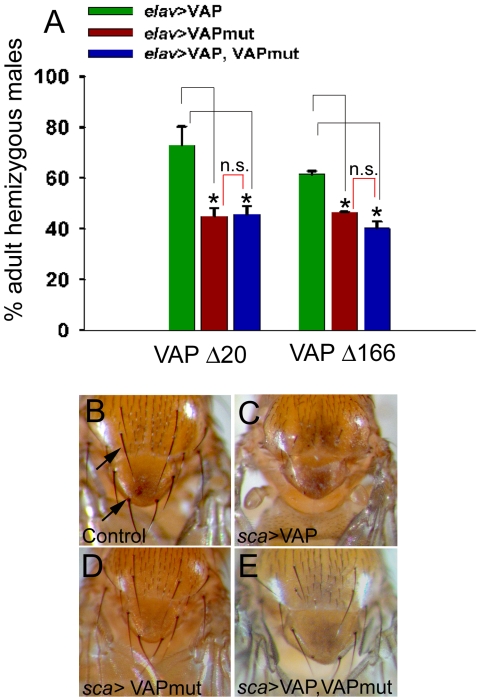
VAPP58S appears to function as a dominant negative by inhibiting the activity of wild type VAP.(A) Histogram comparing the rescue from lethality of VAPΔ20 (null mutant) and VAPΔ166 (partial deletion), using neuronal expression of VAPwt, VAPP58S, or a combination of both. The ordinate represents the percentage of mutant hemizygous males obtained (i.e., VAP mutant hemizygous males/VAP mutant hemizygous males+balancer chromosome males). Each bar represents the mean obtained from at least 2–3 independent experiments. Both VAPP58S and VAPwt are able to rescue the larval lethality observed in VAPΔ20 and VAPΔ166 mutants. However, the percentage of mutant males obtained with VAPwt is higher (72.9±7.3 for VAPΔ20 and 61.5±1.2 for VAPΔ166) as compared with VAPP58S (45.0±3.1 for VAPΔ20 and 46.6±0.06 for VAPΔ166). For each mutant, the value for wild type rescue differed significantly from mutant (p<0.05 for. Δ20 and 0.01 for Δ166; ANOVA with Sidak-Holm test). Rescue of lethality is also obtained by co-expressing VAPP58S and VAPwt. In this case, the percentage of mutant males obtained was similar to that observed with VAPP58S alone (45.7±3.3 for VAPΔ20 and 40.3±2.7 for VAPΔ166). However, for each mutant, rescue using the recombined VAPP58S, VAPwt chromosome differed significantly from that obtained using VAPwt alone (p<0.05 for Δ20 and 0.01 for Δ166, ANOVA with Sidak-Holm test). n.s., not significant. (B–E) VAPP58S suppresses the thoracic bristle phenotype produced by expression of VAPwt using Sca-GAL4. (B) Shown in this panel is the thorax of a control (sca-GAL4/+) adult fly with a stereotyped pattern and number of dorsal macrochaetae (arrows). (C) In Sca-GAL4/UAS-VAPwt animals, the dorsal macrochaetae either fail to develop or are dramatically reduced in number. (D) Expression of VAPP58S has no effect on the development or number of bristles. (E) However, co-expression of VAPP58S with VAPwt results in a suppression of the bristle loss phenotype caused due to overexpression of VAPwt.